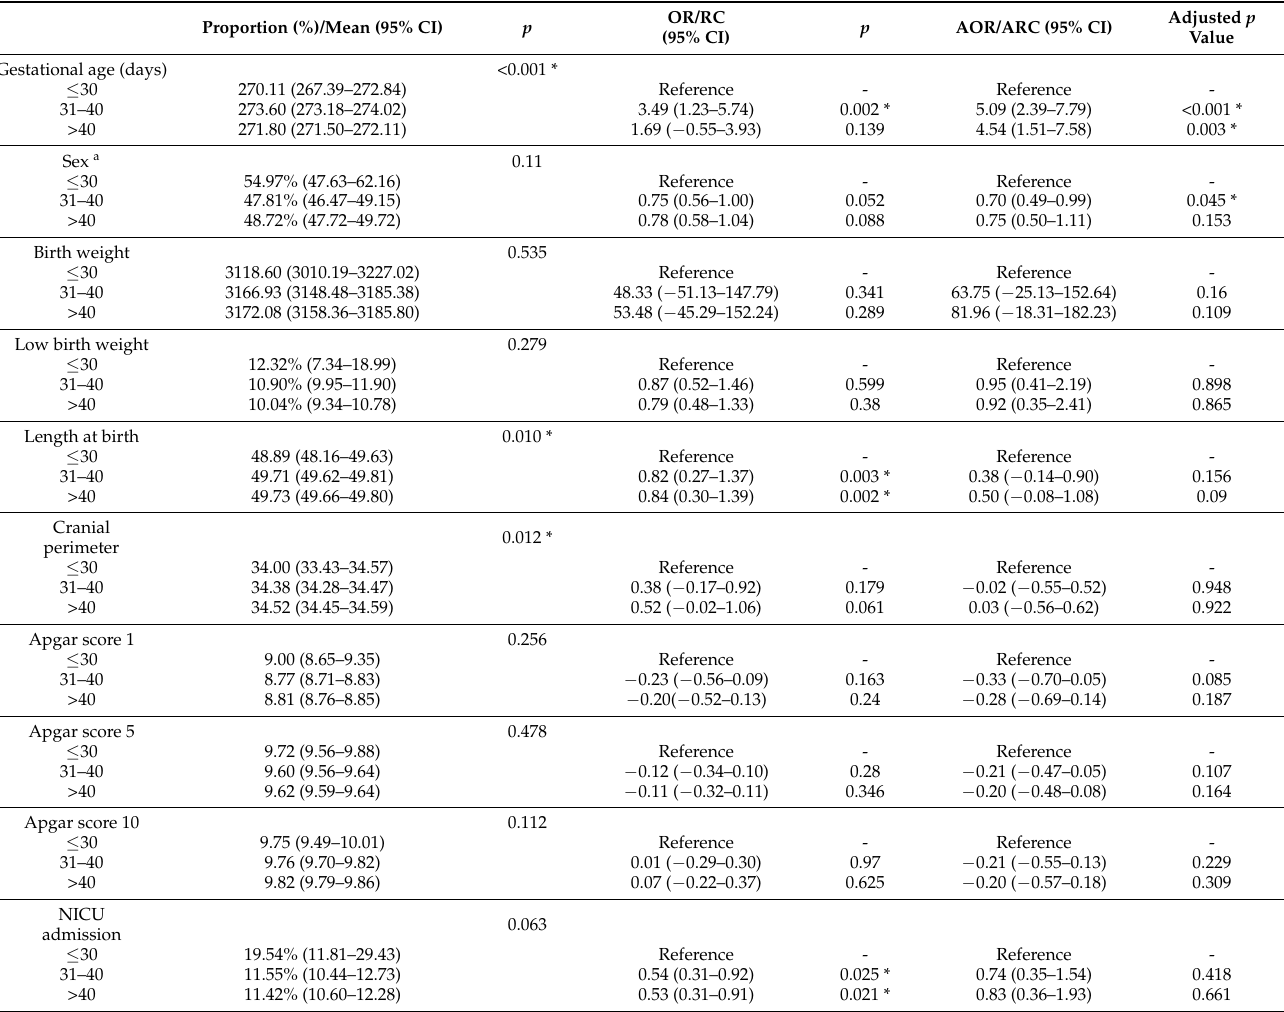
Table 3. Perinatal outcomes associated with paternal age following in vitro fertilization or intracyto- plasmic sperm injection using autologous sperm and donated